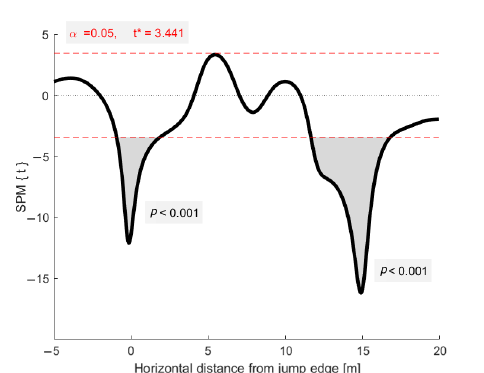
Figure A1. Statistical parametric mapping t-test analysis of the paired difference between the methods compared to zero difference of trajectory ( a ), horizontal and vertical velocity ( b , c ) and acceleration ( d , e ) ( n = 16). The red, dashed, horizontal lines indicate the threshold t ∗ test-values and the values are reported in each plot. Significant supra-threshold clusters are marked with a grey shade, together with their corresponding p